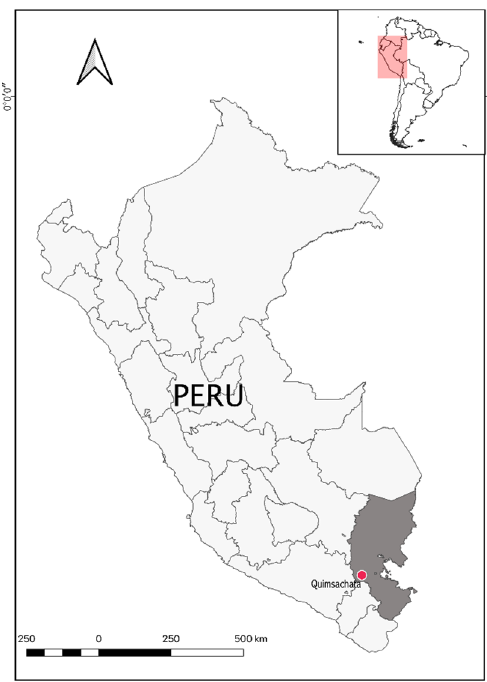
Figure 1. Geographical localization of the Camelid Germplasm Bank—Quimsachata in the Department of Puno, Peru at around 4200 m above sea level (map created with DIVA-GIS software).